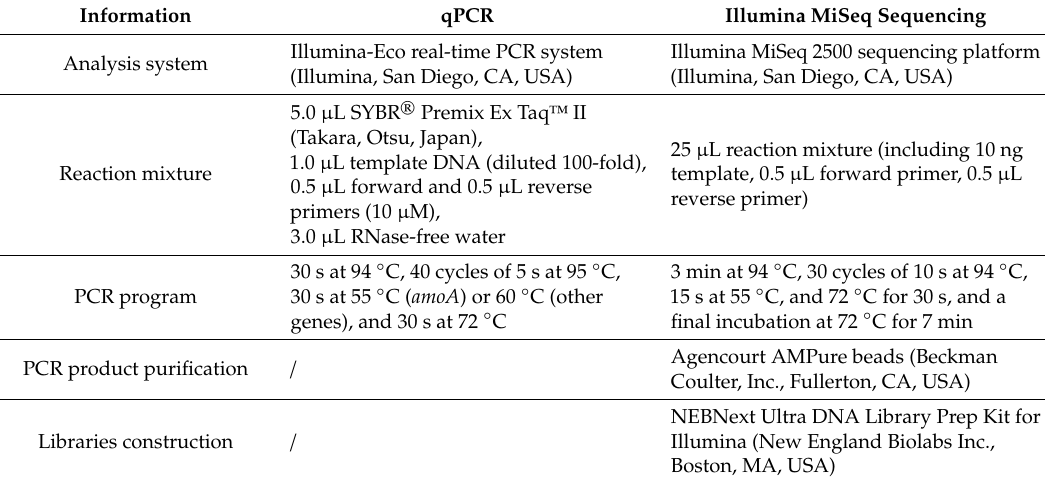
Table A2. Detailed information for 16S rRNA gene qPCR and Illumina MiSeq sequencing analysis.